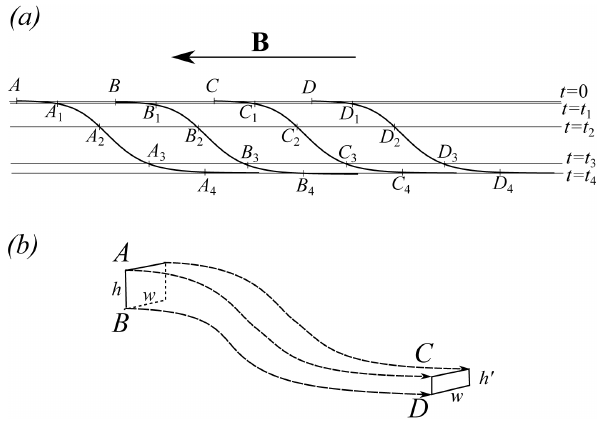
Figure 4. Ray tracing of transverse Alfvén wave in the magnetic field above a current sheet as the sheet current density is increased (see